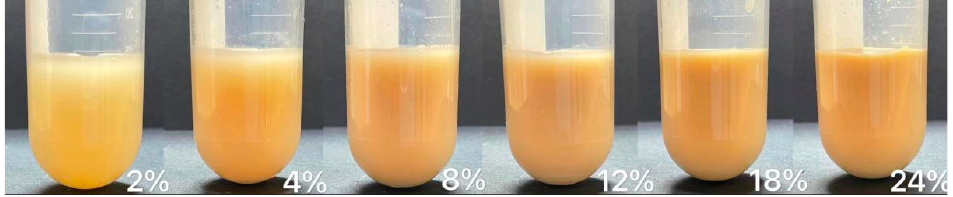
Figure 2. Appearance picture of DCF dispersion with different concentrations.